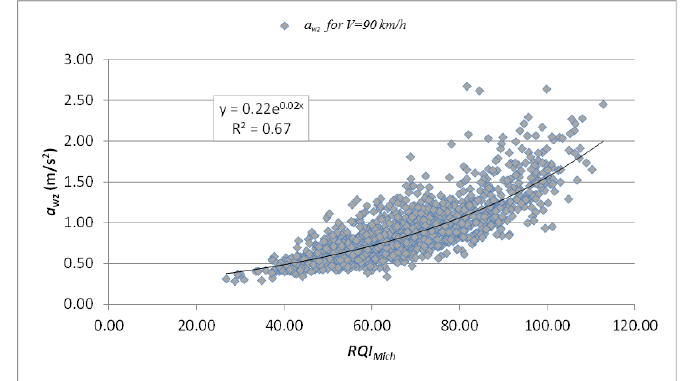
Figure 8. Correlation between RQI Mich and a wz at 90 km/h.